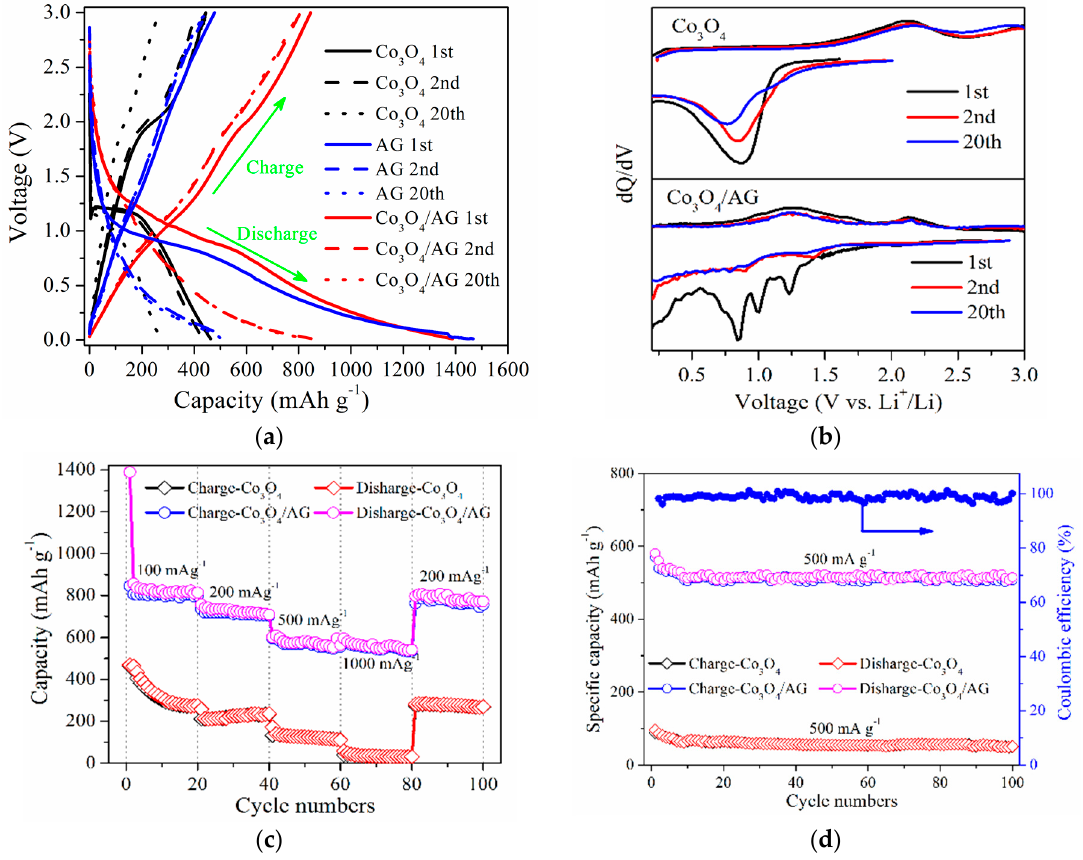
Figure 7. Electrochemical performances of Co 3 O 4 , AG, and the Co 3 O 4 / AG nanocomposite: ( a ) Galvanostatic charge / discharge curves, ( b ) di ff erential capacity curves, ( c ) rate capability at various current densities from 100 to 1000 mA · g − 1 ; ( d ) Cycling performance and coulombic e ffi ciency at a current density of 500 mA · g − 1 for 100